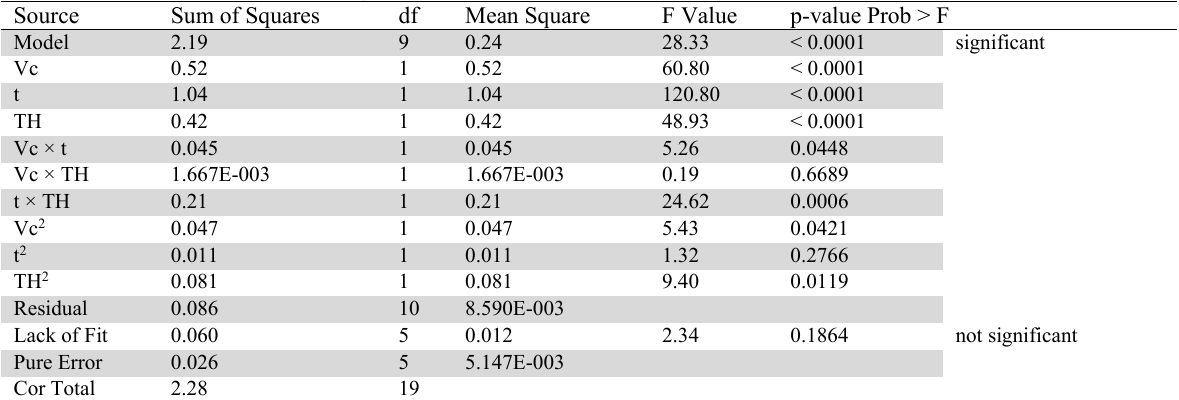
ANOVA results for surface roughness (Ra)